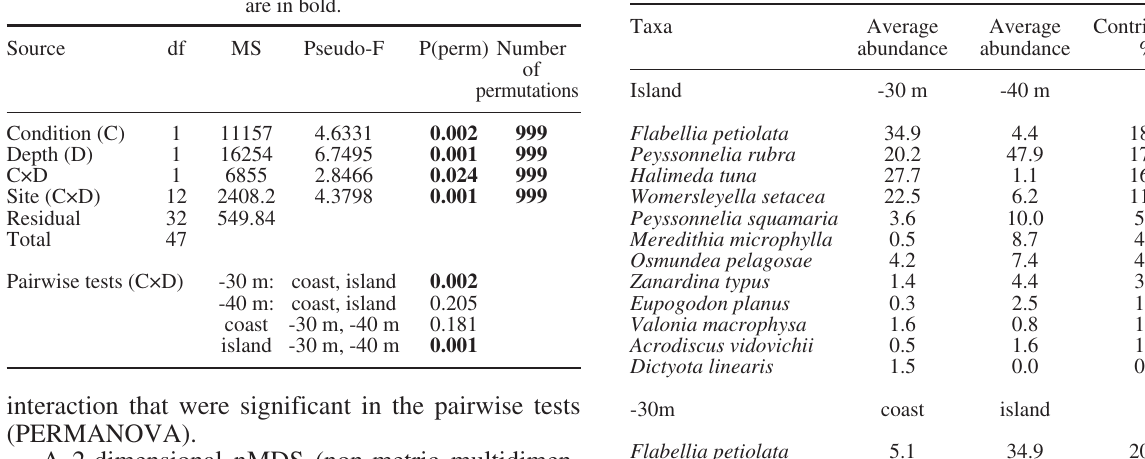
Table 2. – Results of SIMPER